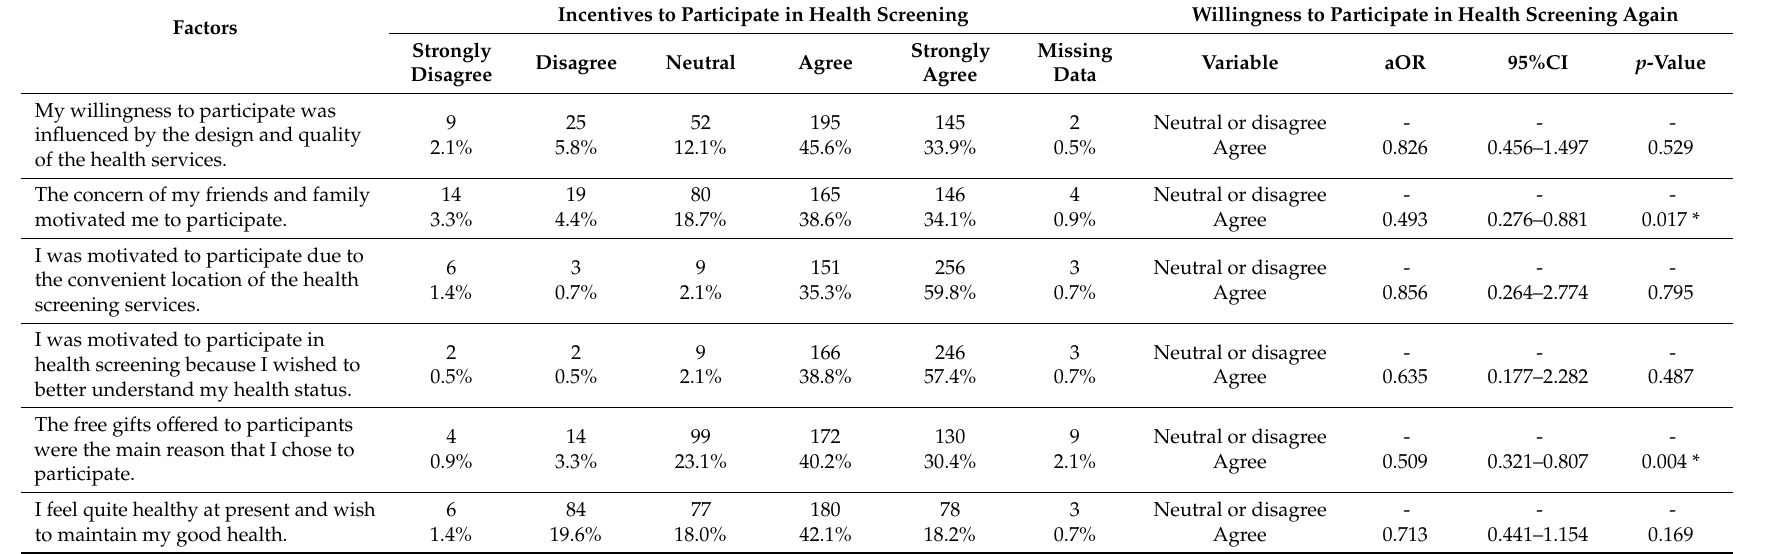
Table 4. Key factors which influence willingness to join health screening services ( N =